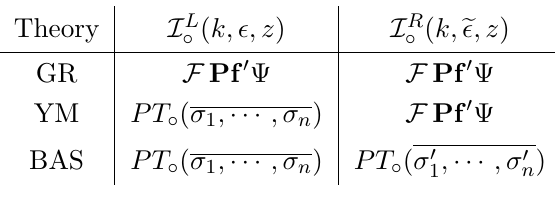
Table 2 . 1 -loop CHY